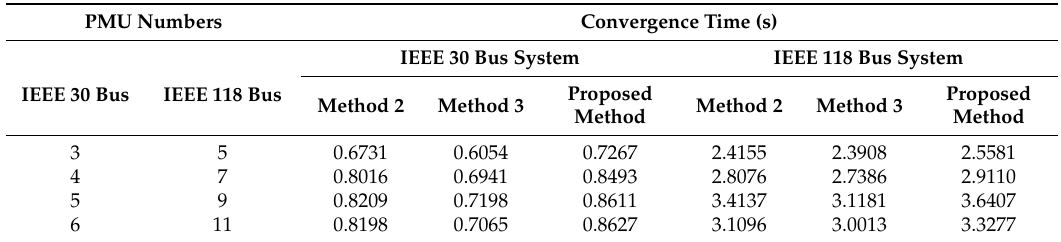
Table 10. The convergence time of proposed method in 30 and 118 bus system.